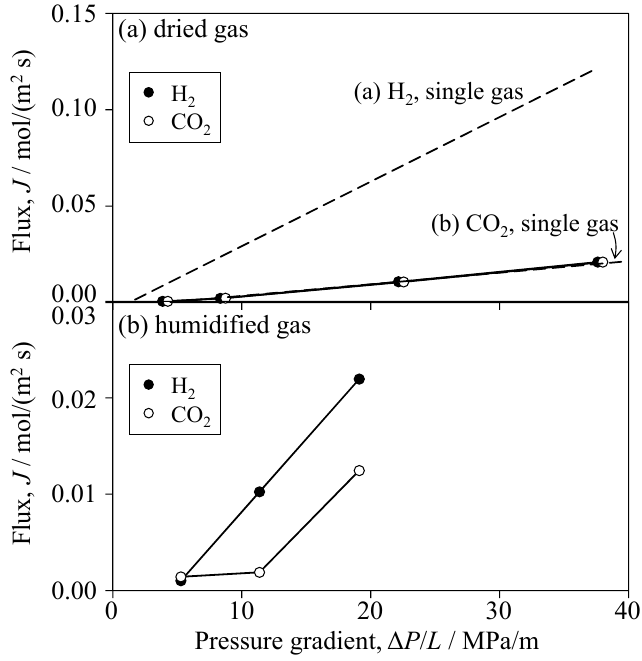
Figure 19. Flux of H 2 and CO 2 gases permeated through Al 2 O 3 porous ceramics (60.9% relative density) for the 50 vol % H 2 –50 vol % CO 2 mixed gas ( a ) with and ( b ) without 3 vol % H 2 O.